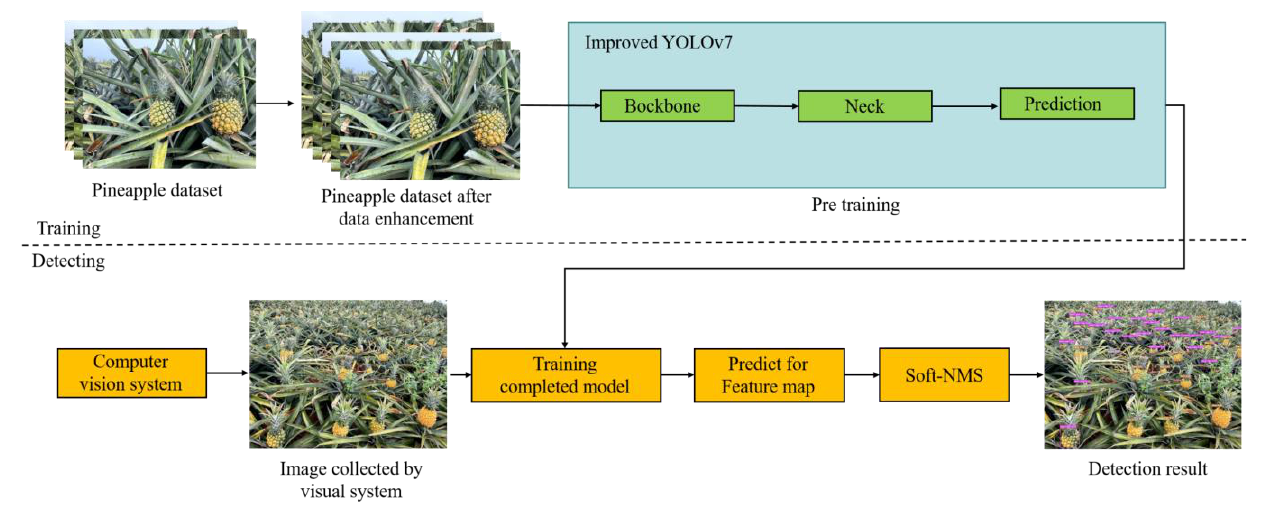
Figure 9. Flow diagram of pineapple detection in the field.